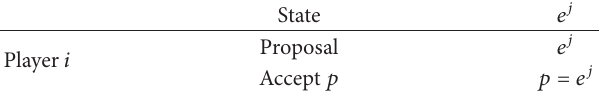
Table 1: Haller’s